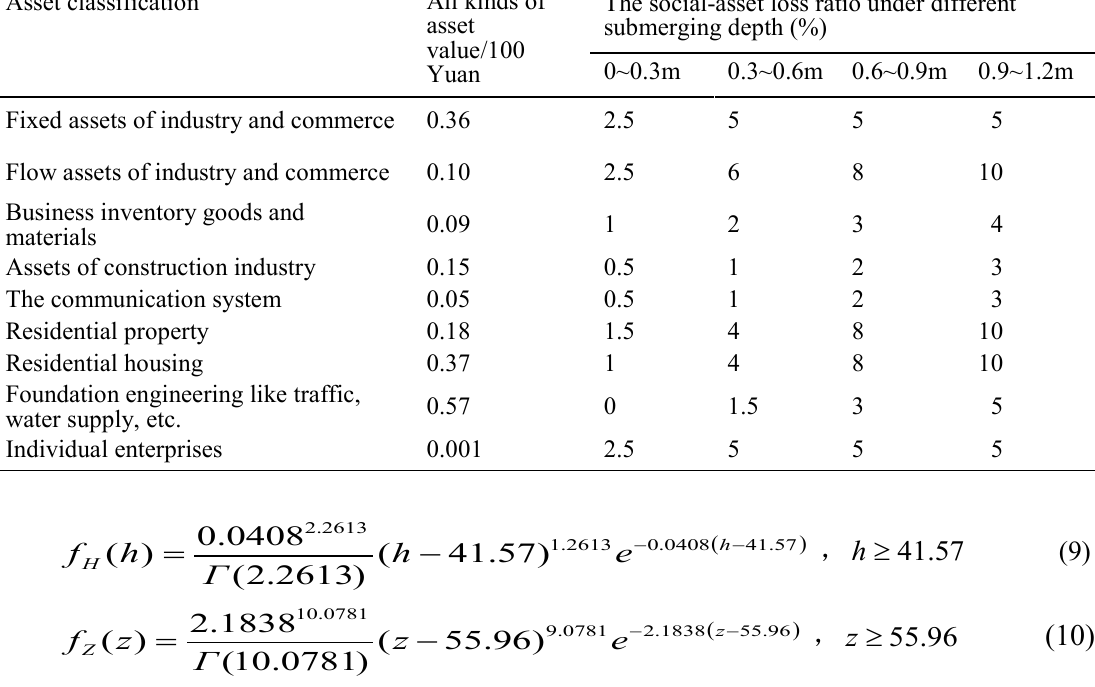
Table 1 The value of each asset and the waterlog loss percentage in the case of different submerge in 2010.